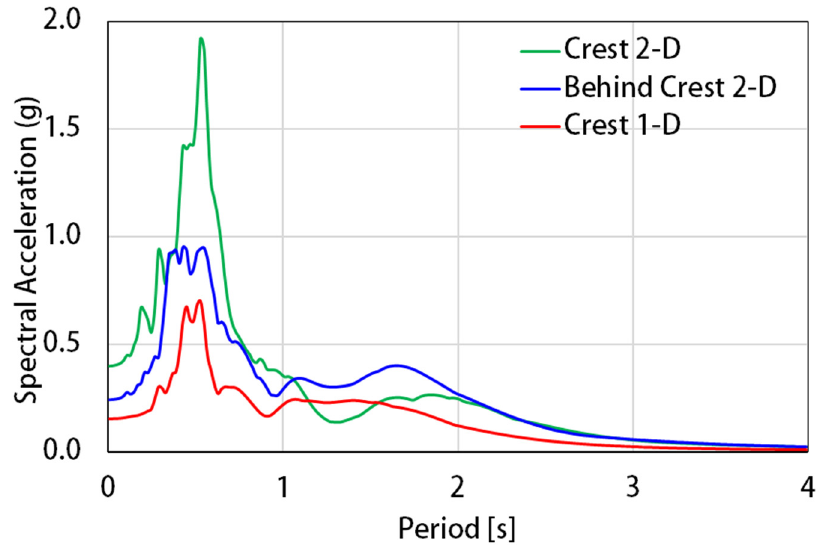
Figure 24. Comparison between elastic response spectra at the crest (1-D and 2-D) and behind the crest (2-D), for the Amoruso et al. [26] input.